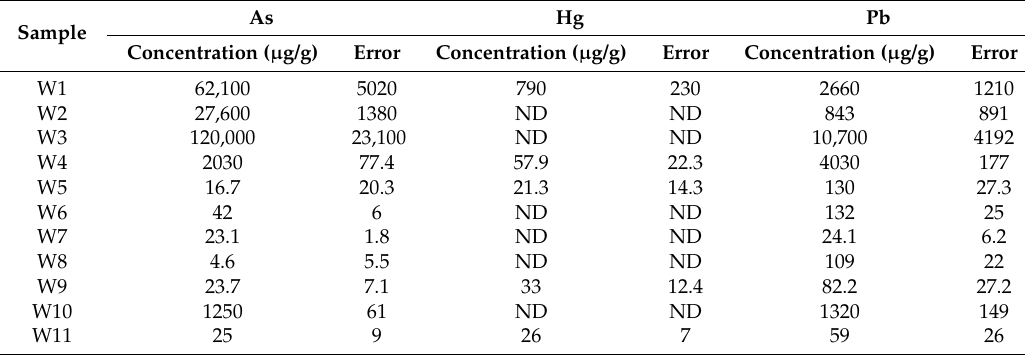
Table 2. Heavy metal concentrations in sediment samples from the upper course to the lower course of Bone River.